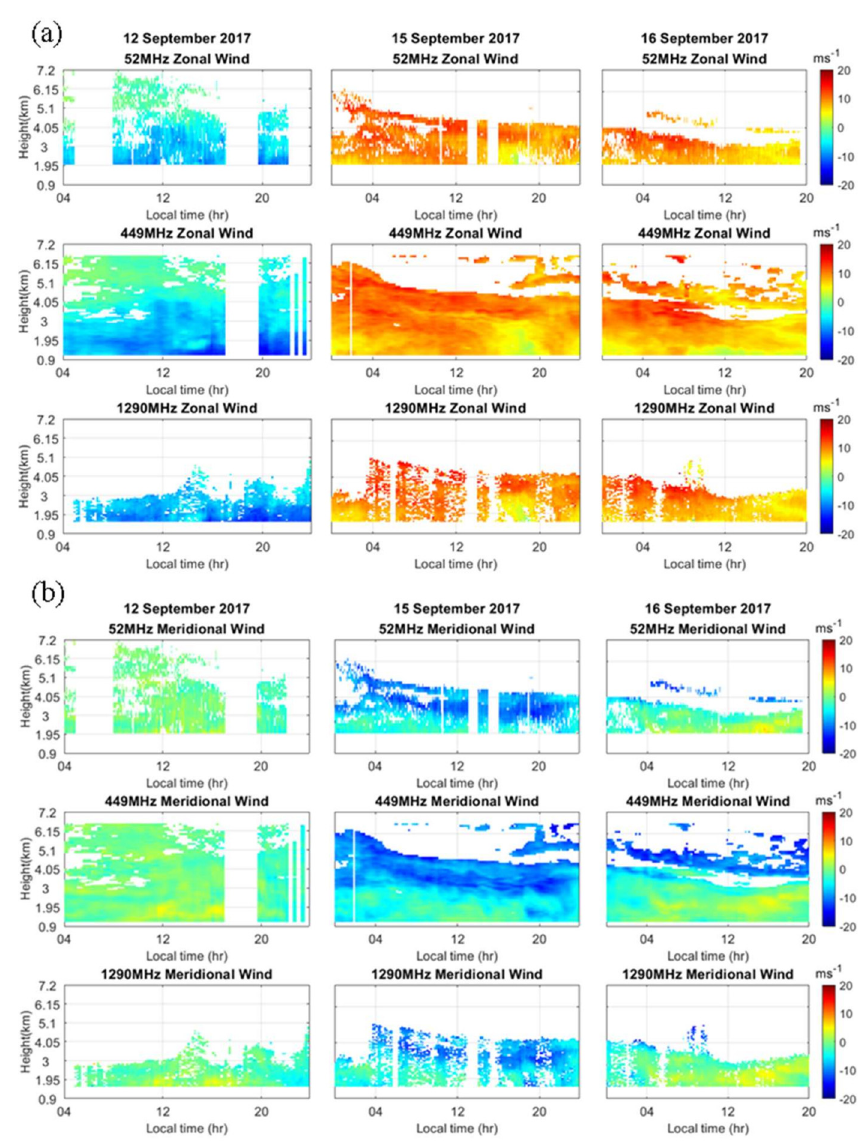
Figure 3. ( a ) Height–time–intensity plots of zonal wind velocities measured by VHF radar (top panels), UHF radar (middle panels), and L-band radar (bottom panels) on 12 September, 15 September, and 16 September 2017 in clear air conditions without precipitation; ( b ) Same as Figure 3a, but for meridional wind